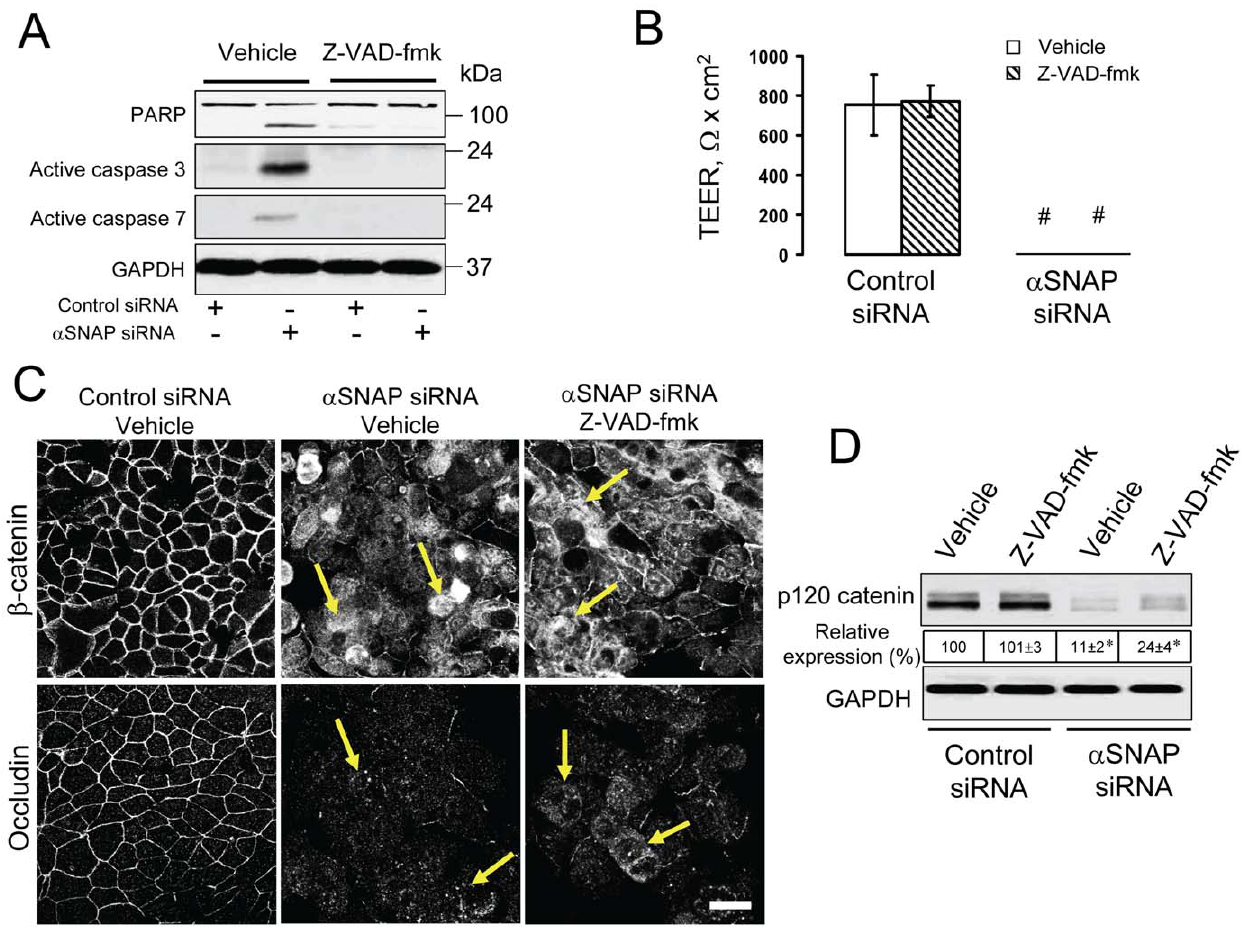
Figure 3. Disruption of apical junctions and downregulation of p120 catenin expression in a SNAP-depleted cells are not mediated by apoptosis. ( A ) Immunoblotting analysis of cleaved PARP and active caspases 3 & 7 shows that a SNAP depletion causes significant cell apoptosis in SK-CO15 cells on day 4 post-transfection, which is prevented by inhibition of caspases with Z-VAD-fmk (50 m M). ( B–D ) To examine the role of apoptosis in junction disassembly, SK-CO15 cells were transfected with either control or a SNAP-specific siRNA (duplex 1), and one day later, were exposed to either vehicle or Z-VAD-fmk (50 m M) for 72 h. Inhibition of apoptosis does not prevent disruption of the paracellular barrier ( B ), disruption of AJs and TJs ( C , arrows) or down-regulation of p120 catenin expression ( D ) in a SNAP-depleted epithelial cells; *p , 0.05, # p , 0.01 compared to the control siRNA-treated group (n=3). Scale bar, 20 m m.